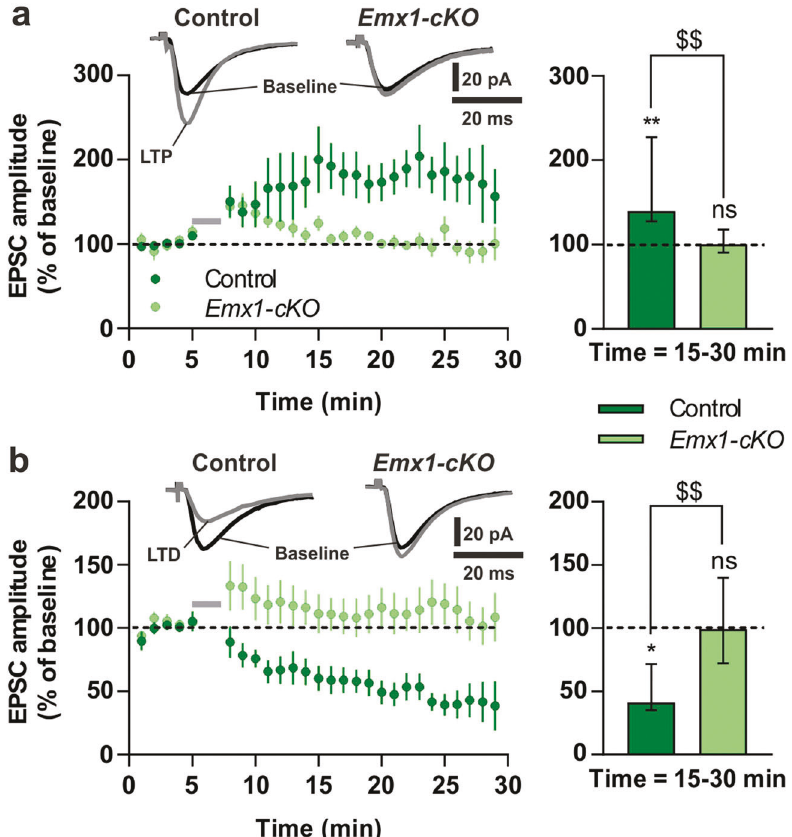
Fig. 2 Impaired corticostriatal synaptic plasticity in Emx1-cKO mice. LTP ( a ) and LTD ( b ) are lost in Emx1-cKO mice. Left graphs: time-course (normalized EPSC amplitude expressed as means ± SEM; gray bars represent induction protocols; 2-way ANOVA from 15 to 30 min; LTP: